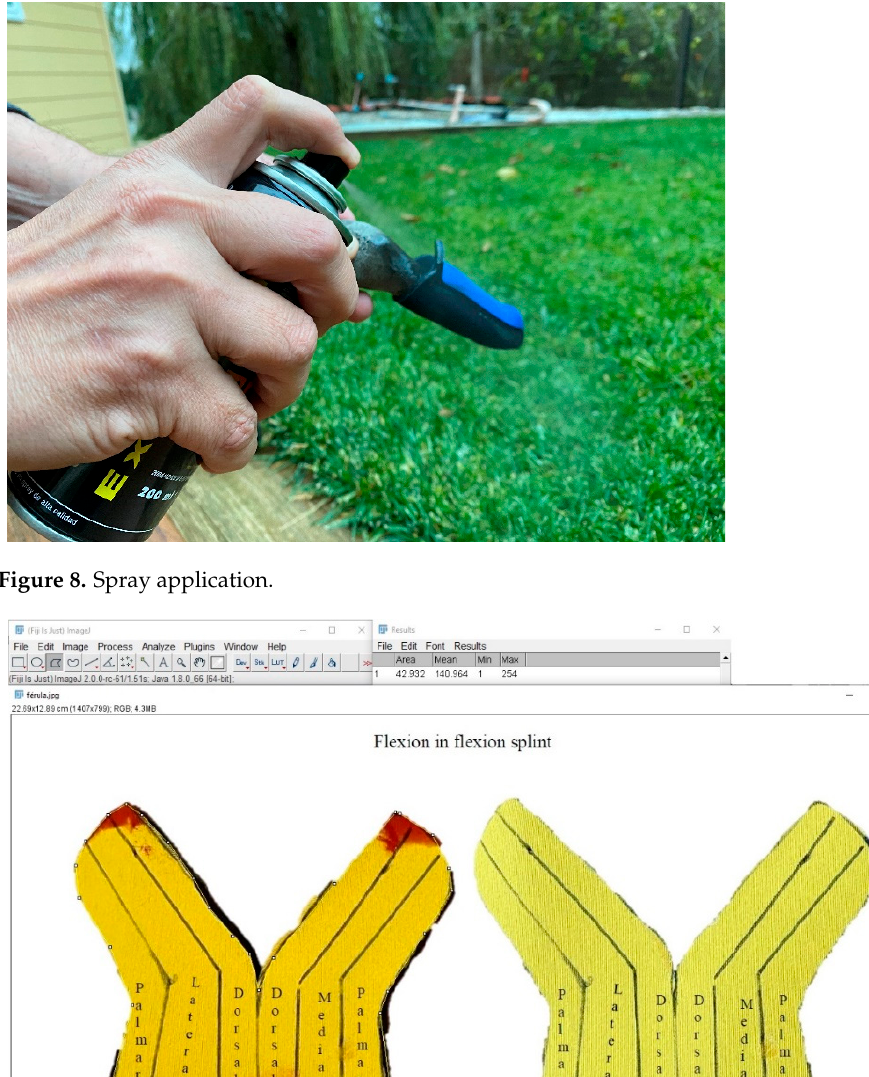
Figure 7. ETDNO pa tt ern lines.